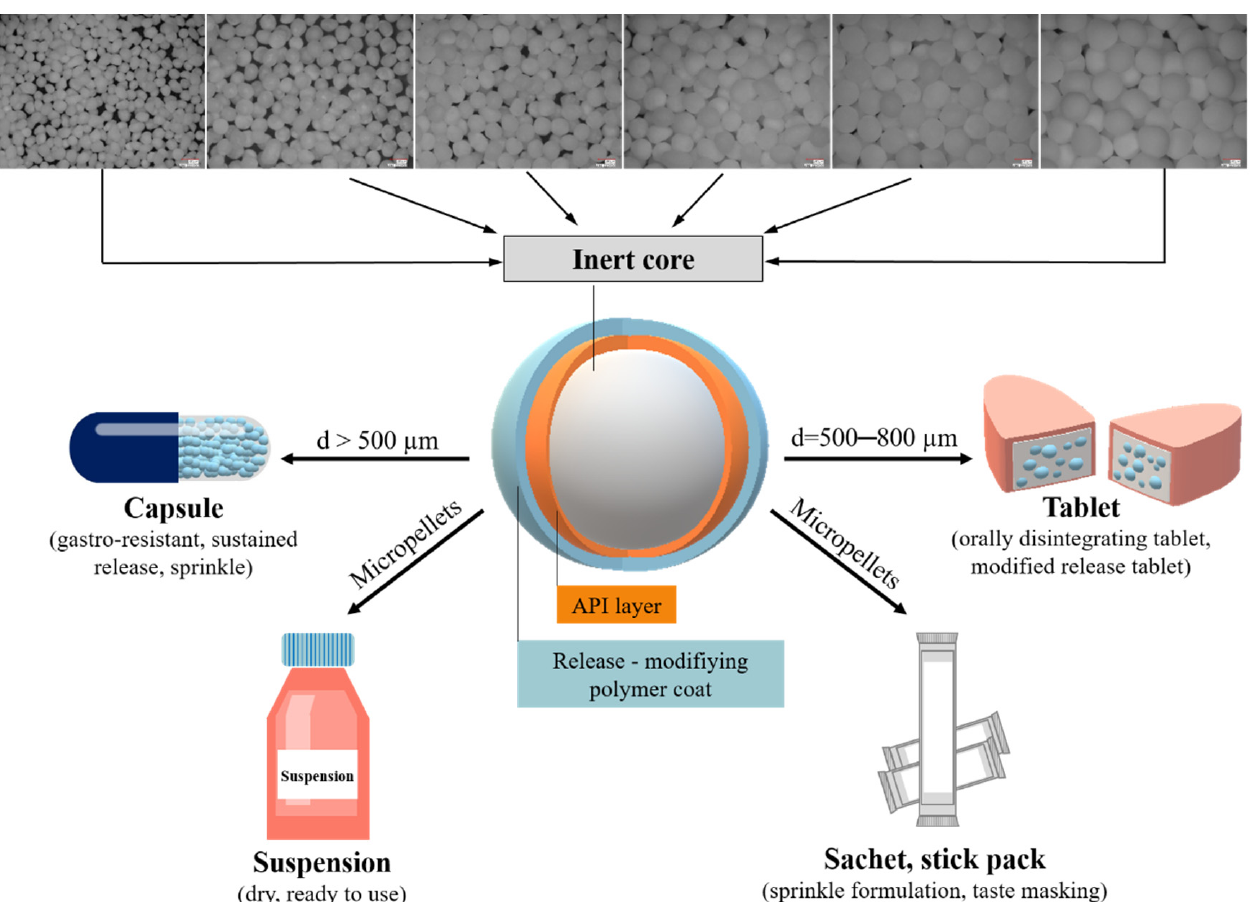
Figure 4. Relationship between particle size and dosage forms (Photo: Keyence VHX 970 digital microscope; inert core: sugar spheres of various particle sizes). Pellet shape: Shape is a critical quality factor, as a rounded/spherical shape is